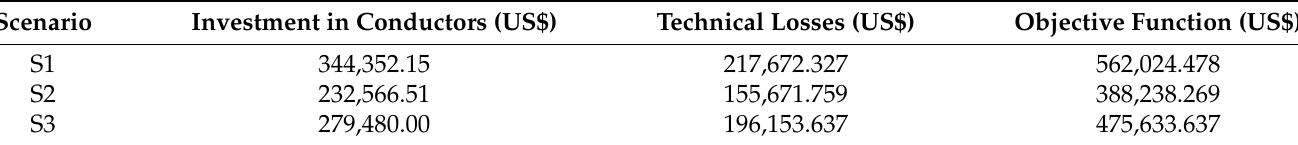
Figure 7. Voltage profile at each node for the hour of maximum demand in the three stages of case 1 of test system 1. Table 14. Investment and operating costs in test system